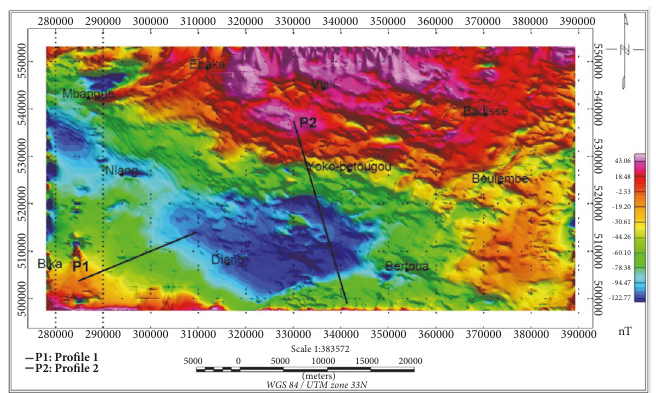
Figure 3: Total magnetic intensity map reduced to the